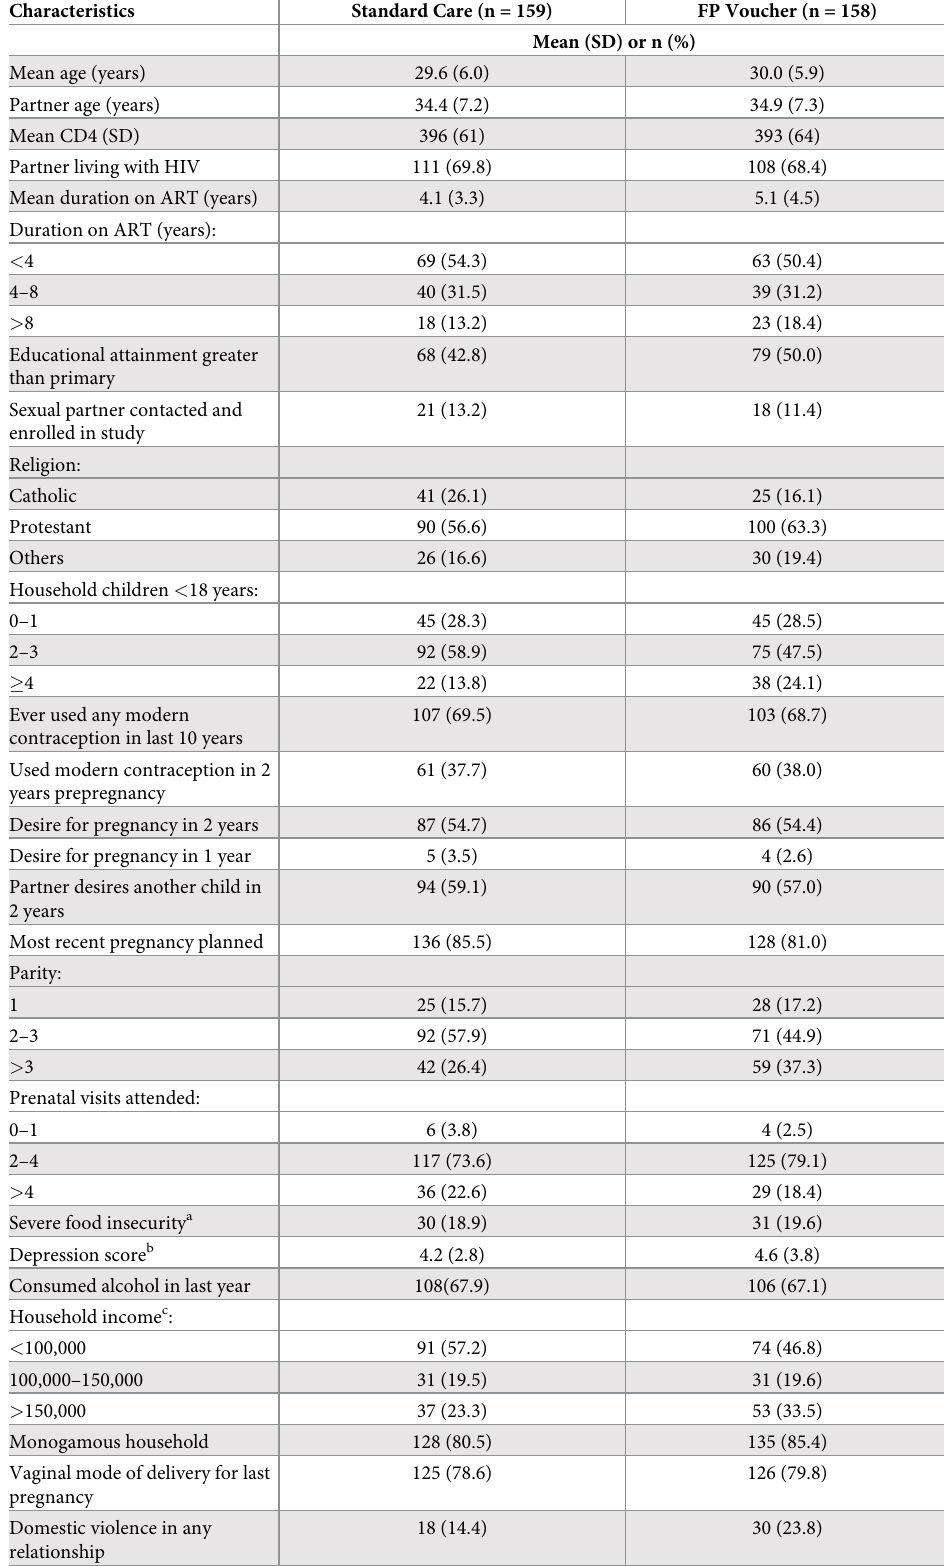
Table 1. Baseline demographic and clinical characteristics of recently postpartum WLWH in Uganda, N =